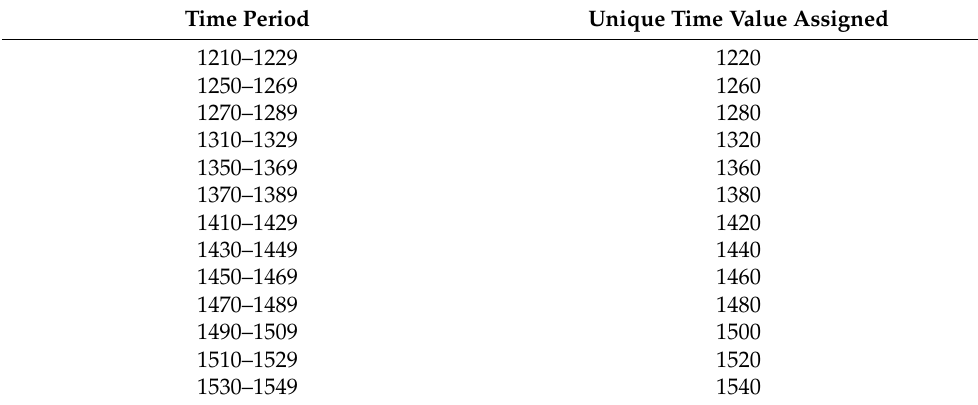
Table 3. Time periods used in the survey. Time